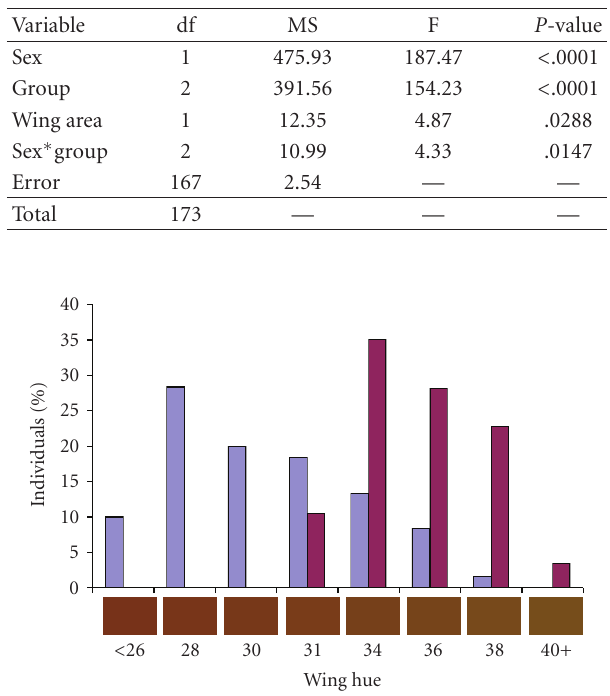
Table 1: Summary of general linear model examining factors influencing wing hue of monarch butterflies in this study. Groups were “breeding,” “overwintering,” and “migrating.” Nonsignificant interaction terms (i.e., where P > . 05) were removed.